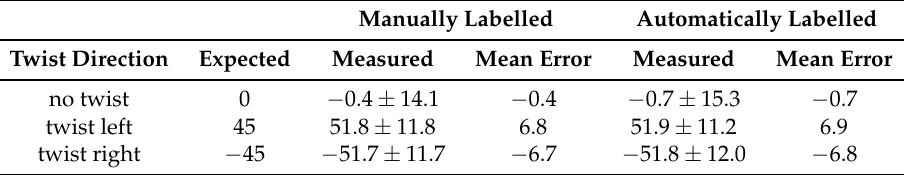
Table 4. The asymmetry angles and errors measured across all 1489 lifts, separated by twist direction. Twists to the left (counterclockwise when viewed from above) are positive angles, while twists to the right are negative. Error was calculated as the estimated angle minus the reference angle. All values are reported in degrees.